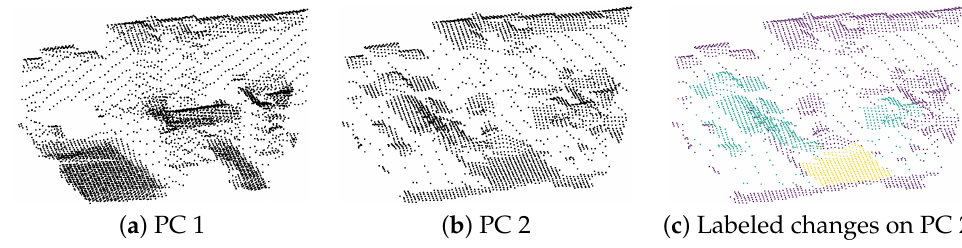
Figure 2. Sample PCs at two time stamps ( a , b ), with new buildings (blue), demolished buildings (yellow) and unchanged objects (purple) in ( c